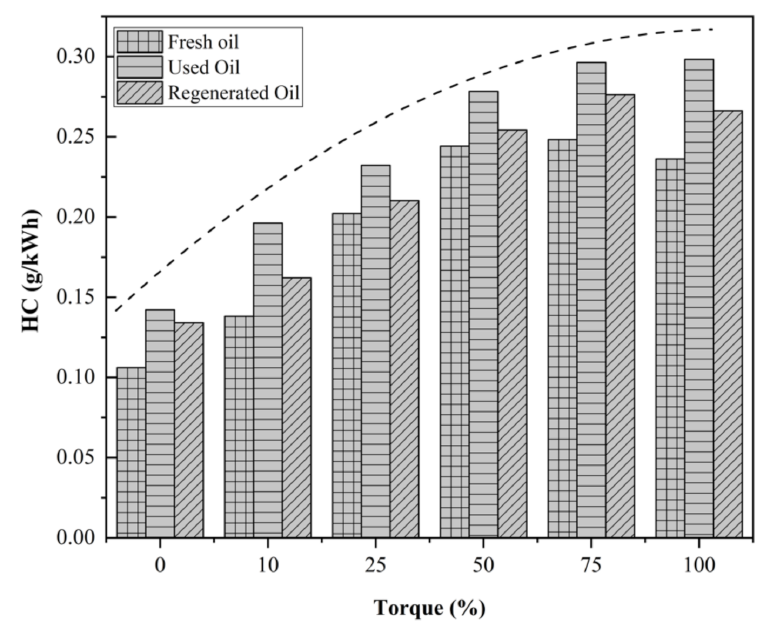
Figure 8. HC emissions variation with torque (%).